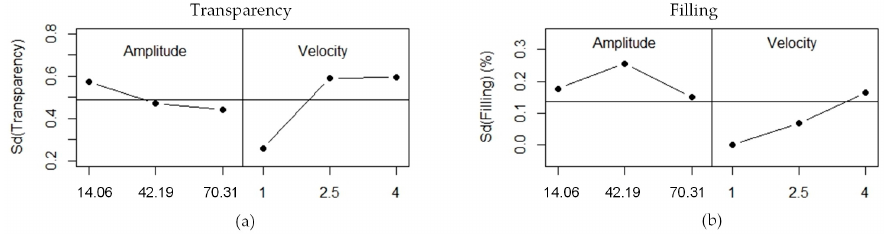
Figure 5. Standard deviation analysis: ( a ) transparency; and ( b ) part filling.